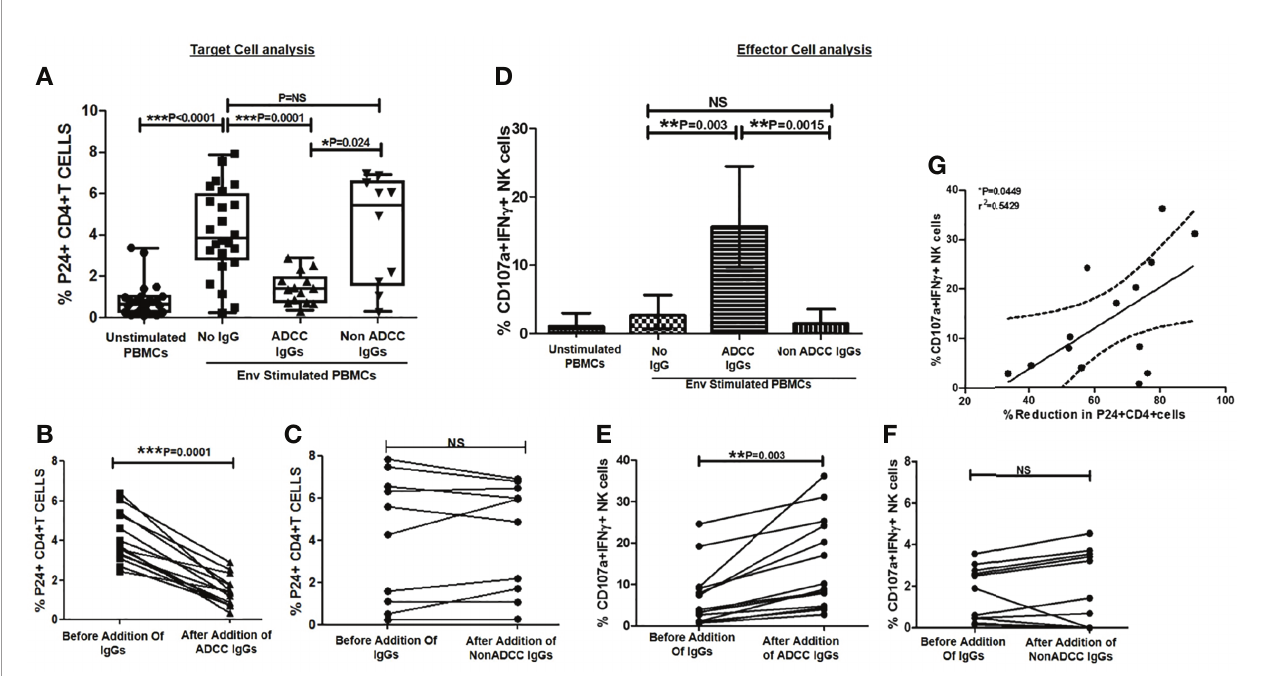
FIGURE 3 | Ability of ADCC antibodies to lyse reactivated HIV-infected CD4+ T cells. (A) Scatter plot shows the frequencies of p24+CD4+ cells (on Y axis) before HIV ENV stimulation, after stimulation with HIV-1 C Env peptide pool and after addition of ADCC IgGs or non-ADCC IgGs(on X axis). The graph (B) shows frequencies of p24 +CD4+ cells (on Y axis) before and after addition of ADCC IgGs (on X axis) in 14 paired samples (P = <0.0001). The graph (C) shows frequencies of p24+CD4+ cells (on Y axis) before and after addition of non-ADCC IgGs (on X axis) in 10 paired samples. (Wilcoxon Matched paired test) (D) The bar diagram shows CD107a and IFN g secreting NK cells (on Y axis) before HIV ENV stimulation, after stimulation with HIV-1 C Env peptide pool, and after addition of ADCC IgGs and non-ADCC IgGs (on X axis). The graph (E) shows percent CD107a+IFN g + NK cells (on Y axis) before and after addition of ADCC IgGs (P = 0.003) and (F) non-ADCC IgGs in 14 and 10 paired samples respectively (Wilcoxon Matched paired test). (G) The scatter dot plot represents the positive association between the % reduction in p24+CD4+ cells (on X axis) with frequency of CD107a and IFN g secreting NK cells (on Y axis) in ADCC responders. (Spearman correlation analysis, P < 0.05). NS, not signi fi